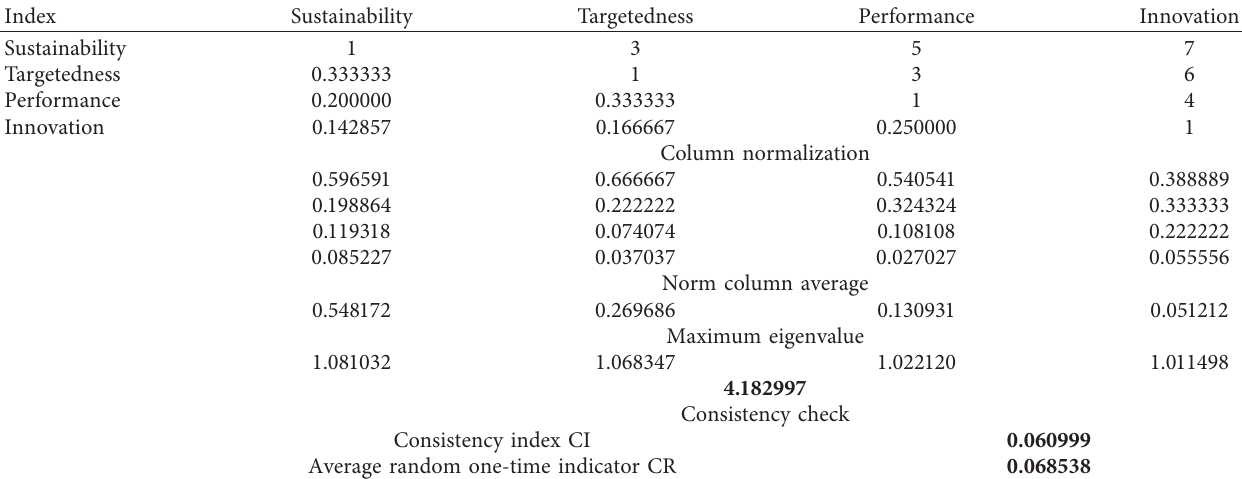
Table 3: Weights of the four factors at the criterion